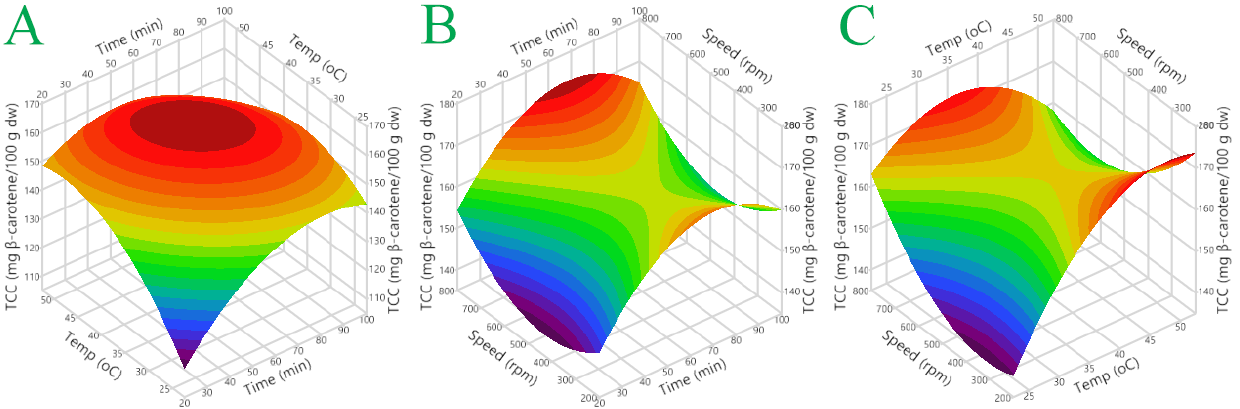
Figure 6. For the extraction of APW using n -hexane: acetone: ethanol (2:1:1), 3D graphs showing the impact of the process variables taken into consideration on the response. Plots ( A , B ) show the covariation of X 1 ( t ) and X 2 ( T ), X 1 ( t ) and X 3 ( S ), and ( C ) the covariation of X 2 ( T ) and X 3 ( S ).